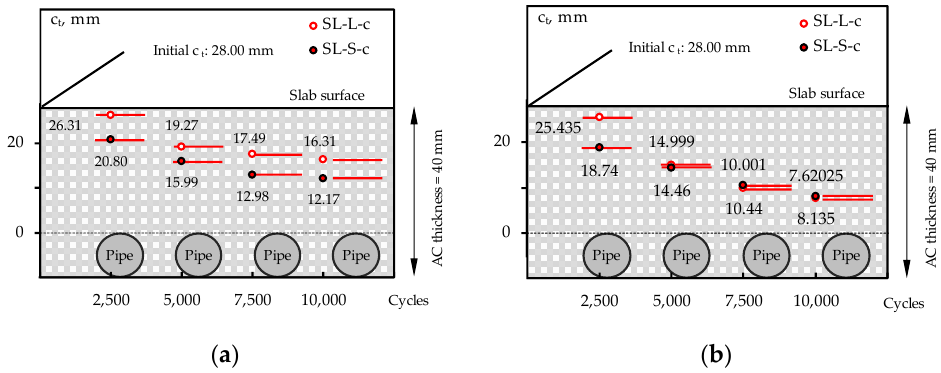
Figure 14. Evolution of covering thickness above the coil: central ( a ) and more-critical ( b ) sections.